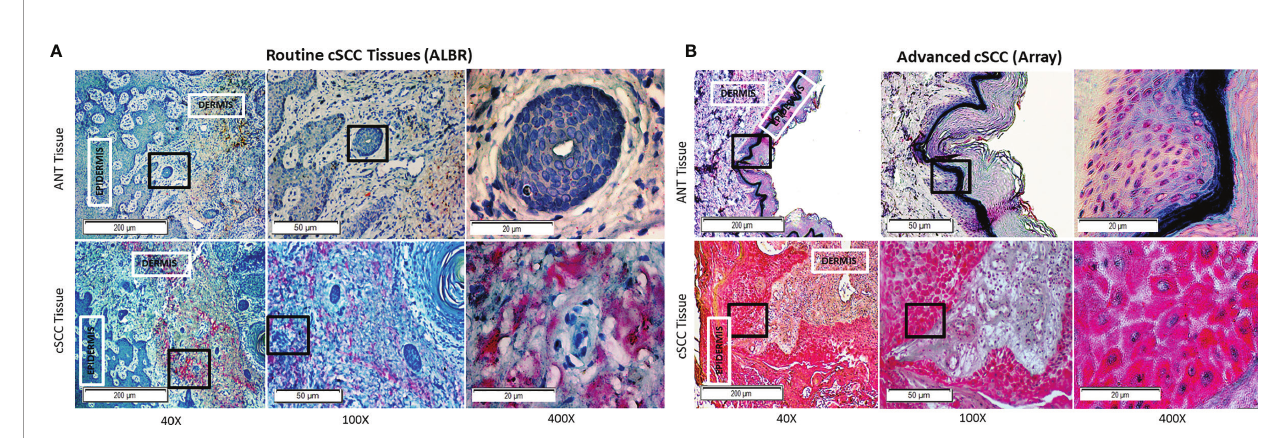
FIGURE 5 | CFH in Routine Mohs and Advanced cSCC Samples by IHC. cSCC removed from routine clinic patients by Mohs surgery [ fi xed after cryosectioning; (A) ] and an array of advanced cSCC [formalin fi xed; (B) ] were labeled with mouse anti-CFH (OX-24) and an AP-conjugated secondary antibody with permanent red stain. Mayer ’ s Hematoxylin was used as a counterstain (nuclei). The degree of CFH staining in the ANT and cSCC samples was semi-quantitatively determined by using a 0-3+ scale, with 0 indicating no staining, 1+ indicating <10% staining, 2+ indicating 10-50% staining, and 3+ indicating >50% staining. ANT samples [ (A, B) , top panels] were scored as either 0 or 1+, the Mohs cSCC samples [ (A) , bottom panel] were scored as 2+, and the advanced cSCC samples [ (B) , bottom panel] were scored as 3+. The boxes within the 40x and 100x images delineate the tissue location shown in the 100x and 400x images,